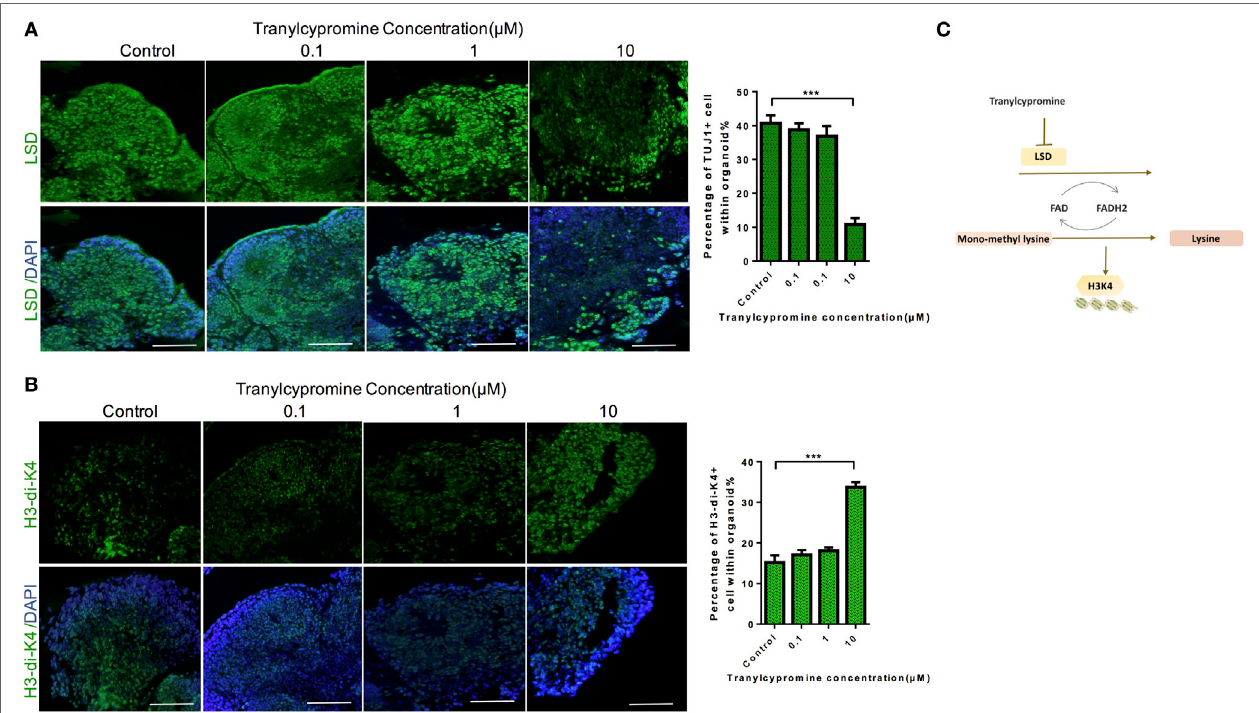
FigUre 5 | Tranylcypromine inhibited BHC110/LSD1 and increased the expression of histone di-methylated K4. (a,B) Immunostaining for the expressions of LSD1 and H3 dimethyl K4 (B) after tranylcypromine treatment. (c) Schematic diagram showing tranylcypromine inhibits BHC110/LSD1 histone demethylation